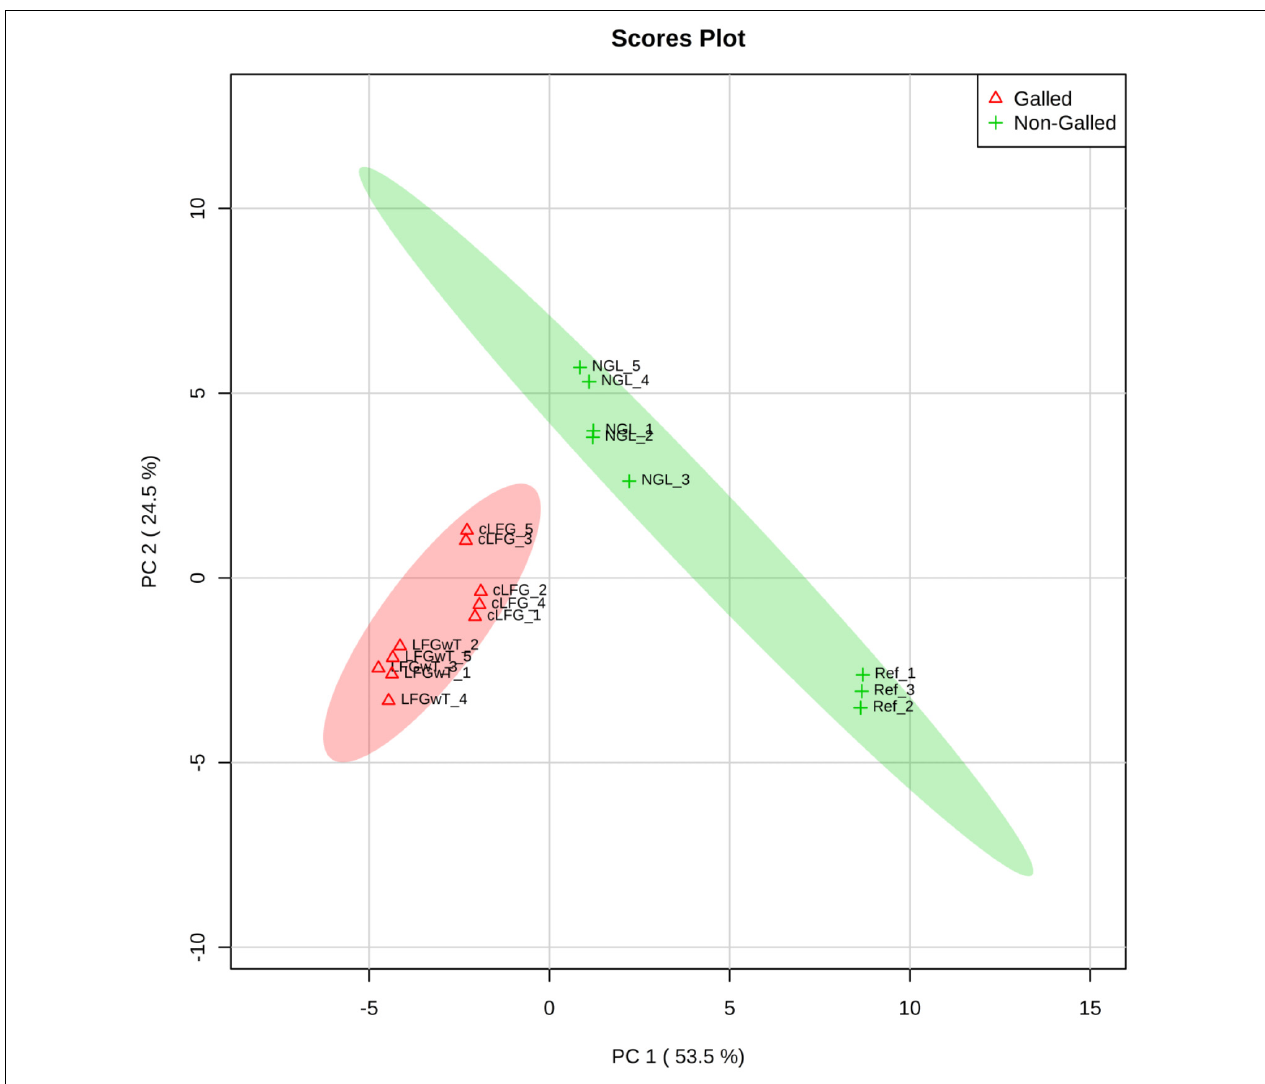
FIGURE 4 | Profile of the distribution of VOCs in non-galled leaves and galls. Plot depicts the distribution of VOC profiles of leaves (non-galled samples, including NGL and Ctrl) and galls (including LRGwT and cLRG samples) over the PCA score plot defined by the first two principal